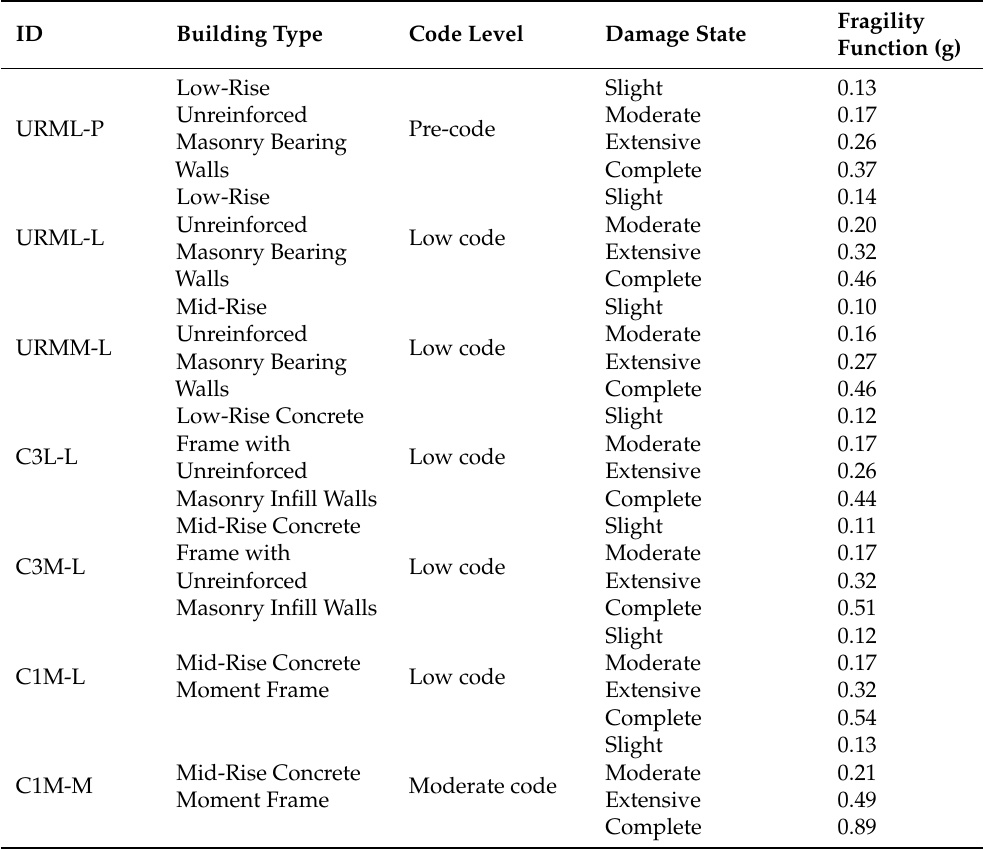
Table A1. Fragility functions utilized for different building types.